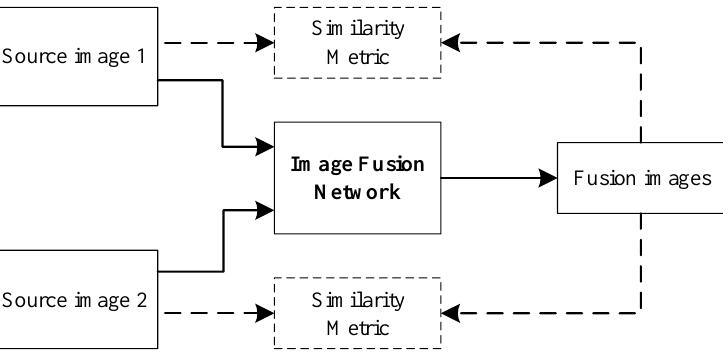
Figure 4. CNN-based image fusion framework.